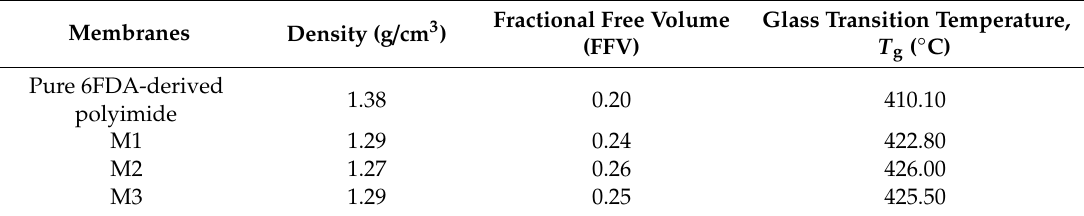
Table 1. Properties of fabricated pure 6FDA-derived polyimide and impregnated Linde T hybrid